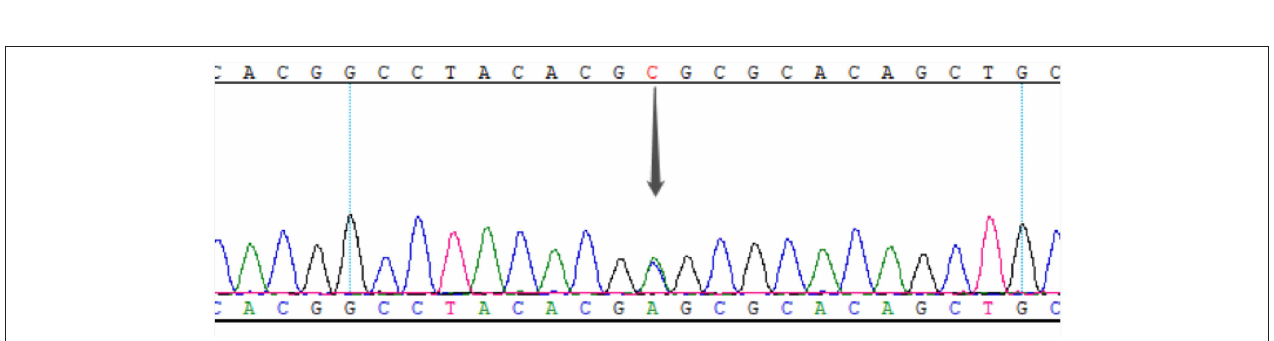
FIGURE 2 | Results of Sanger sequencing of exon 2 in PDX1 of the proband. The gray arrow indicates the c. 463C > A heterozygous